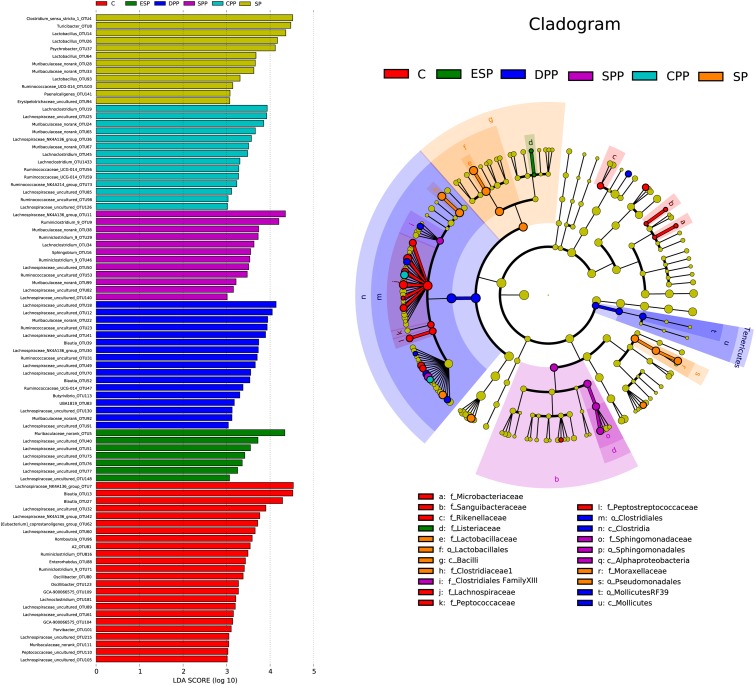
Linear discriminant analysis of caecum microbiota. The left histograms show the LDA scores computed for features at the OTU level. The right biologically cladograms show specific gut microbial taxa from phylum to genus associated with protein diets. C, casein; CPP, cooked pork protein; DPP, dry-cured pork protein; ESP, emulsion-type sausage protein; SP, soy protein; SPP, stewed pork protein.